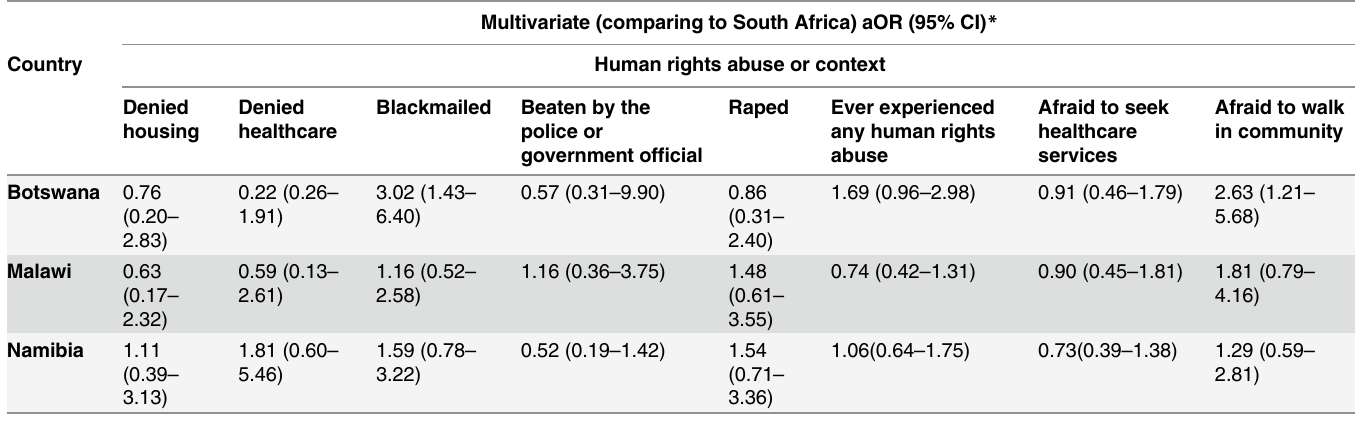
Table 4. Multivariate regression analyses of differences by country in human rights abuses reported by